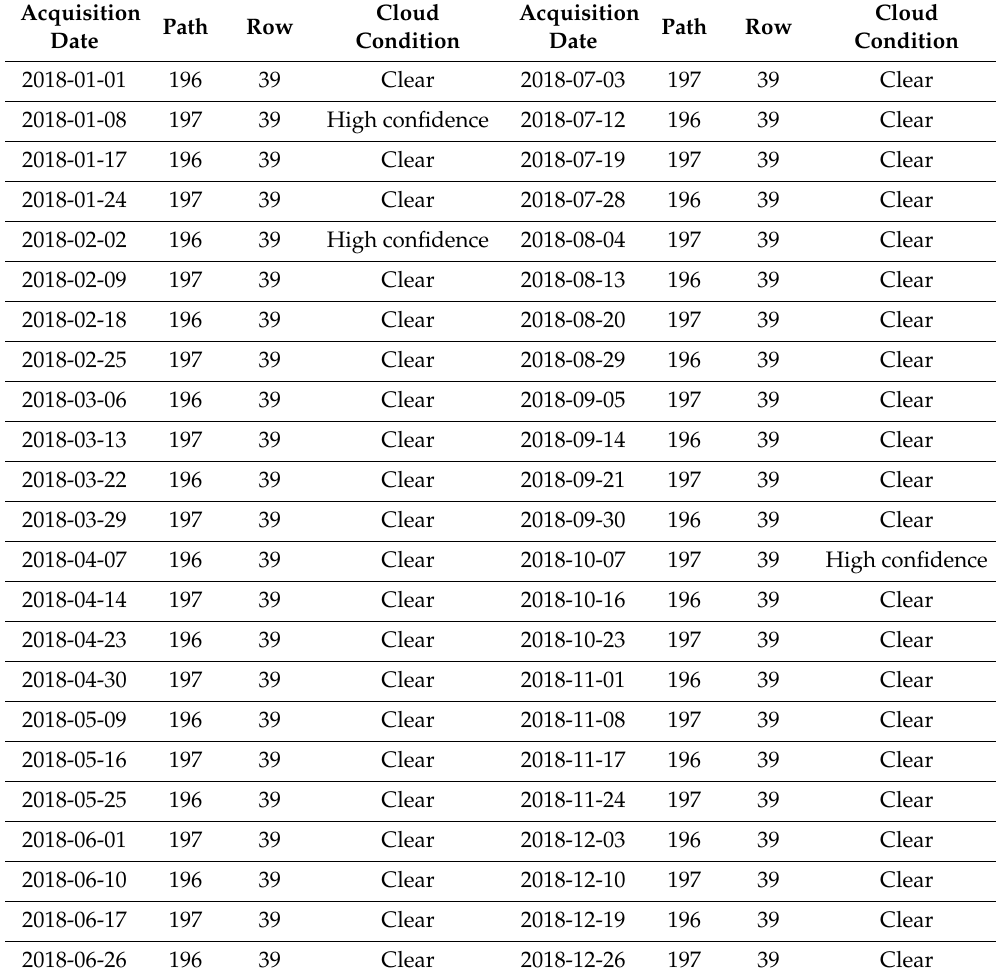
Table 3. Acquisition date, path, row, cloud condition of Landsat-8 acquisition imageries covering the selected location in the northwest of Algeria (30.0 ◦ N, 0.0 ◦ ) in the year 2018.